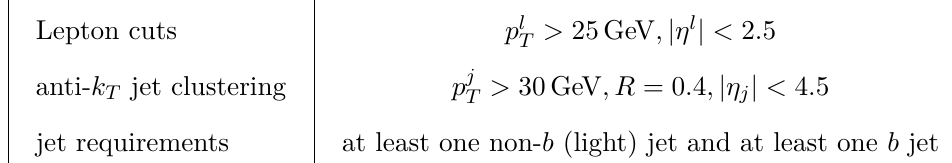
Table 8 . Our fiducial cuts at